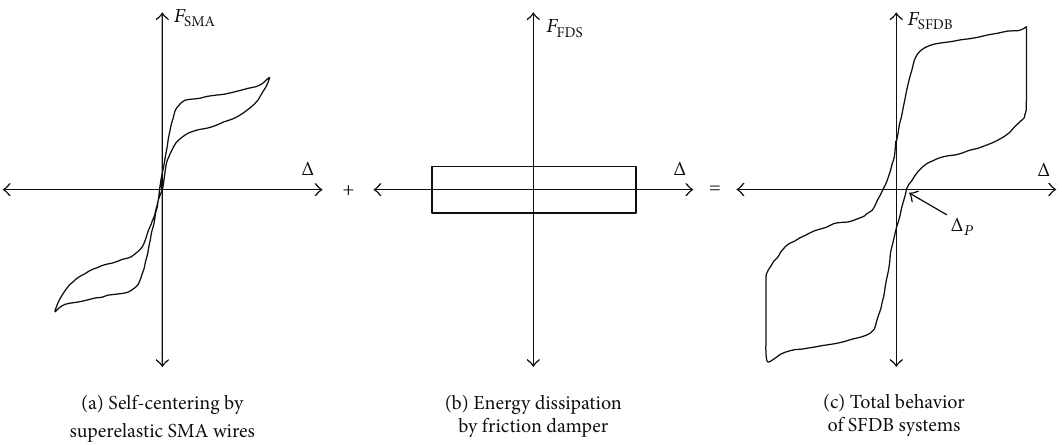
Figure 3: Response mechanism of SFDB